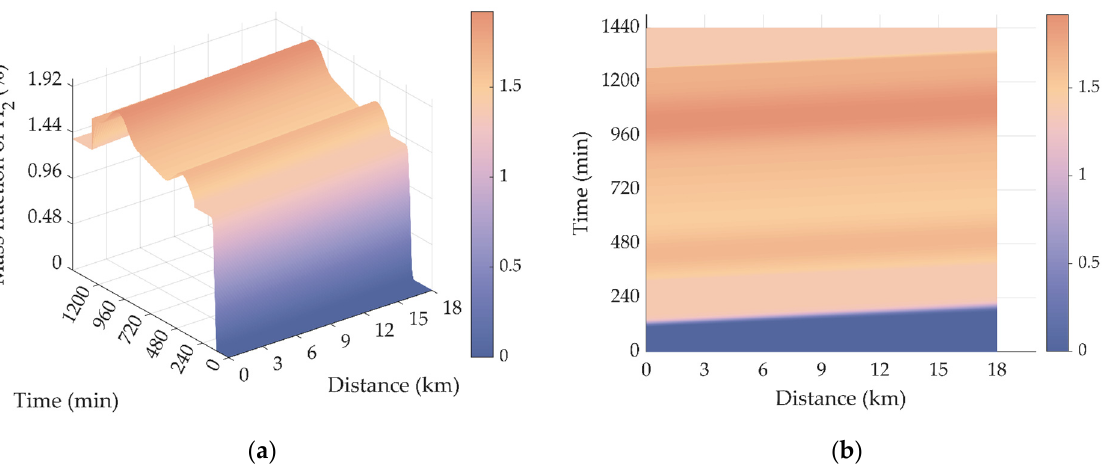
Figure 10. The distribution of hydrogen mass fraction in Pipe 3 in Scenario I: ( a ) Three-dimensional diagram; ( b ) top view.